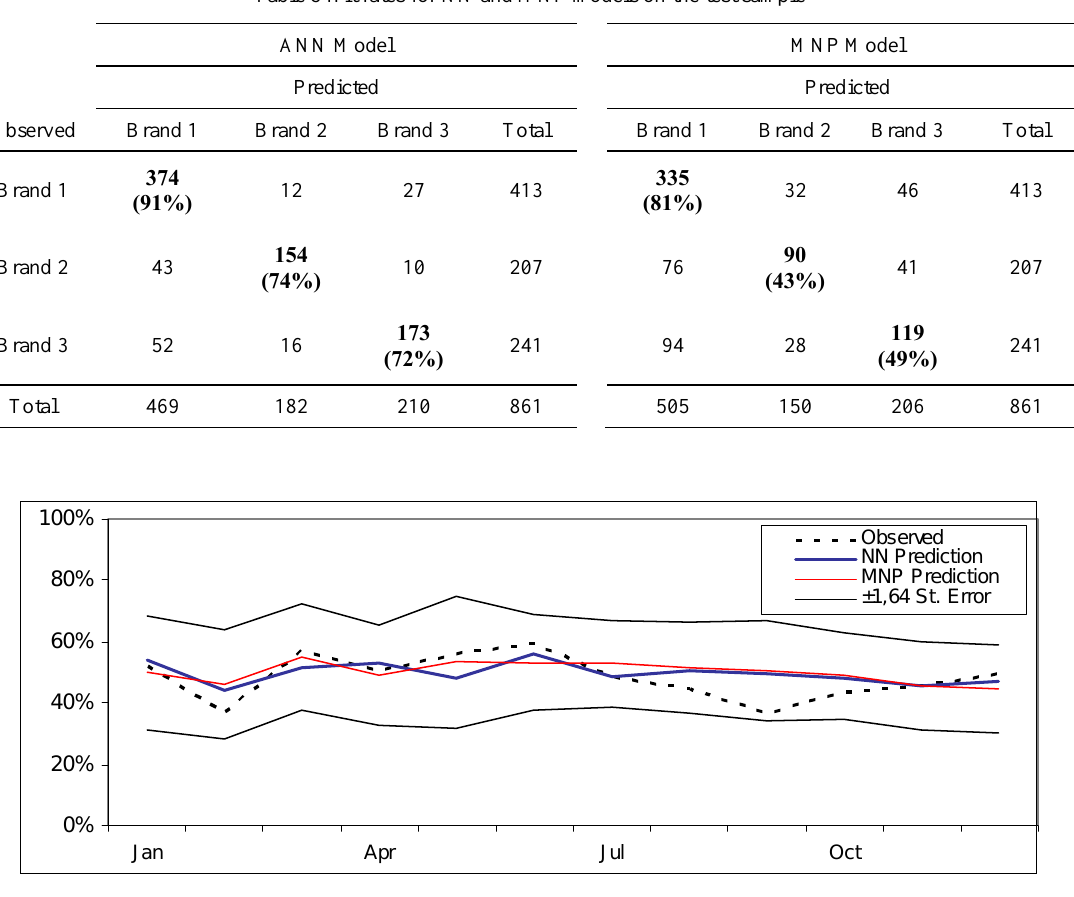
Figure 5 Predictions of Brand 1 monthly share of purchases within the holdout